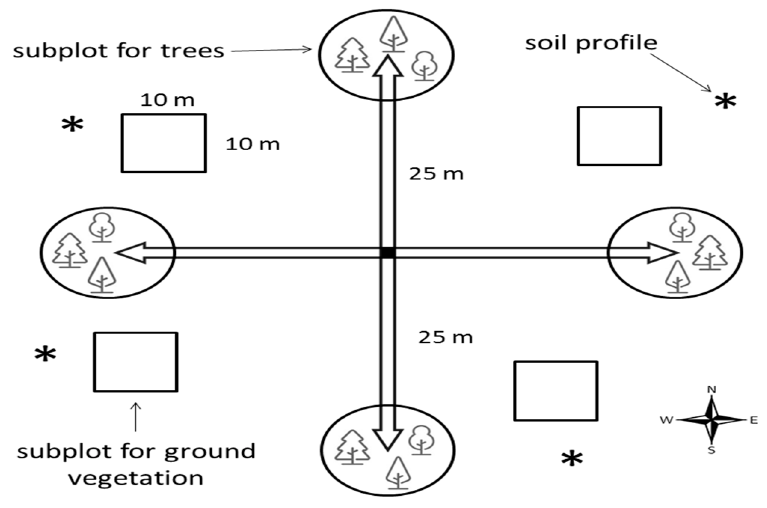
Figure 2. Monitoring plot design.